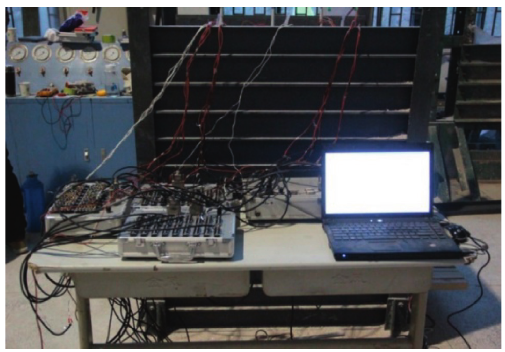
Figure 6: Stress-strain monitoring system.